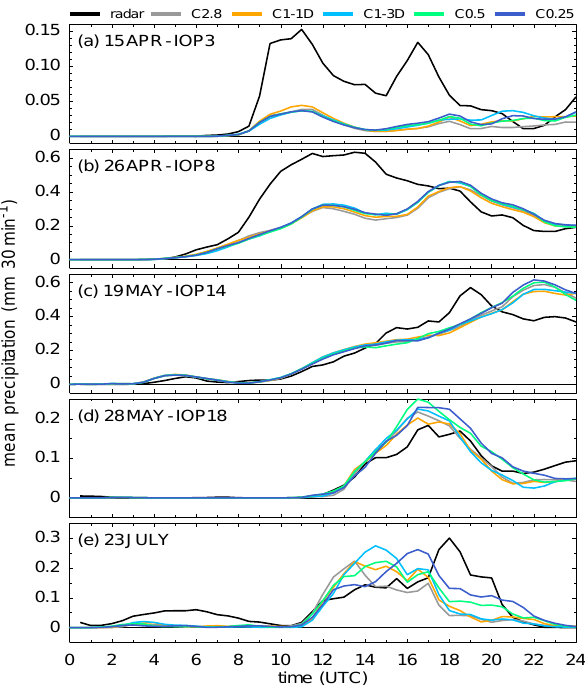
Figure 10. Simulated and radar-derived mean precipitation rates of the common investigation